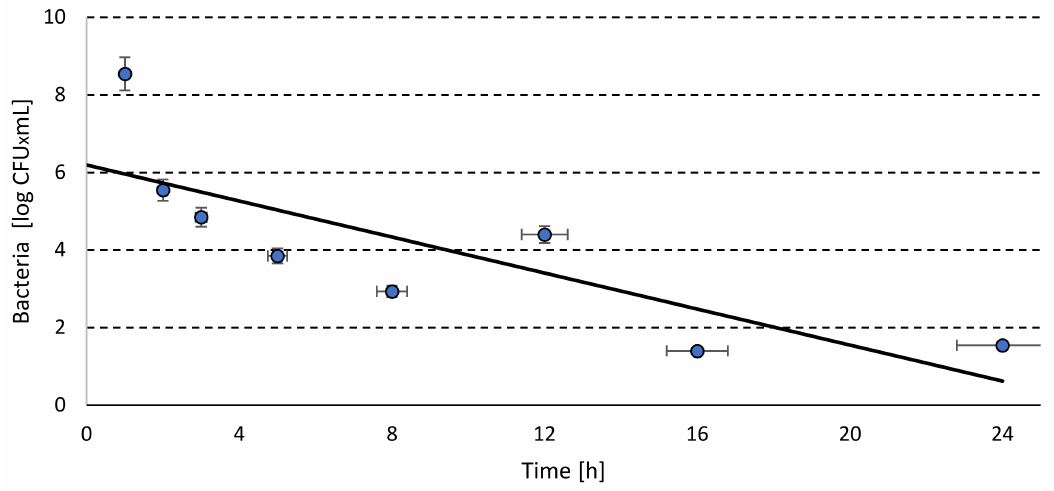
Figure 5. The regression line for kinetics change of the Enterococcus population in laboratory